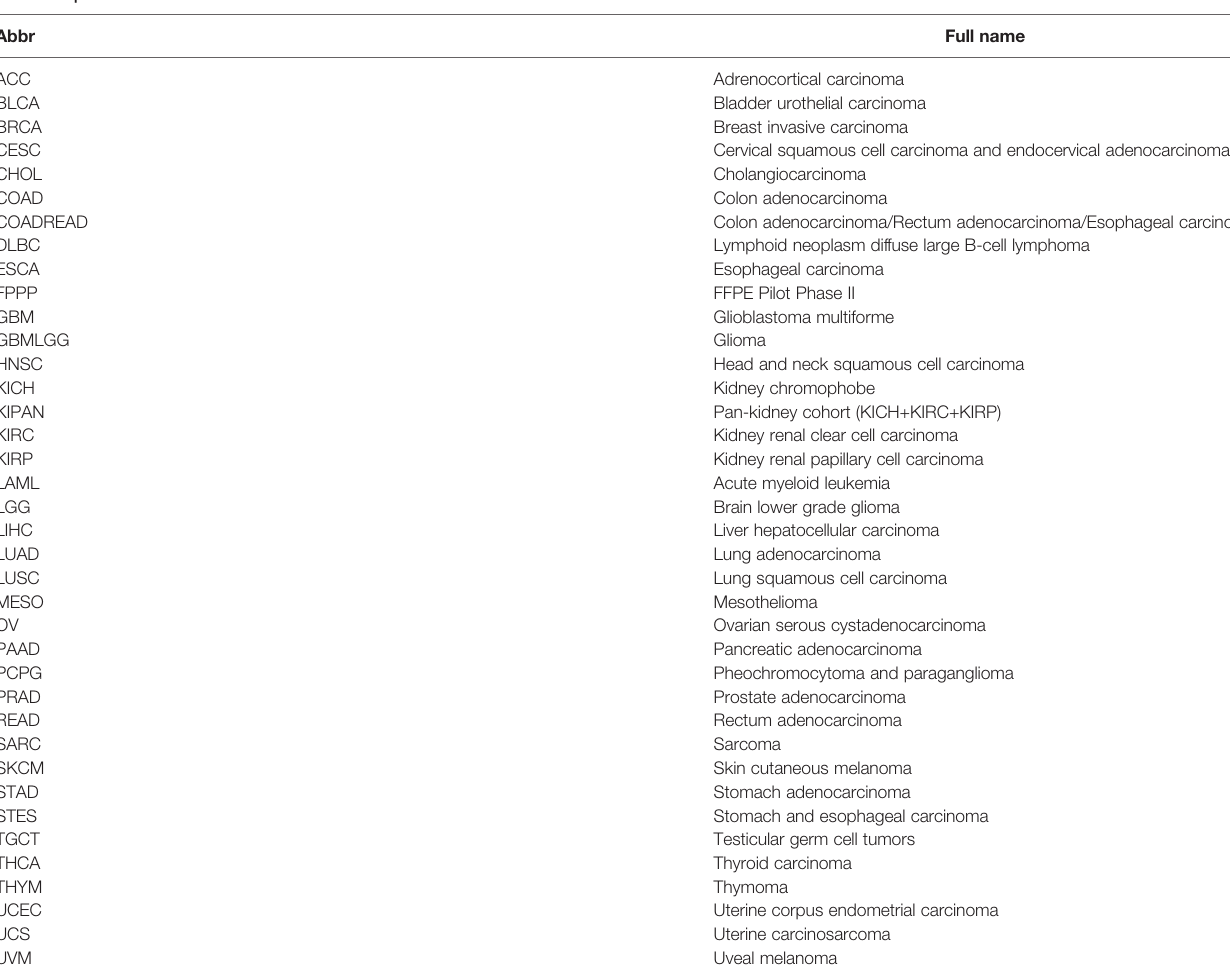
TABLE 1 | TCGA database tumor